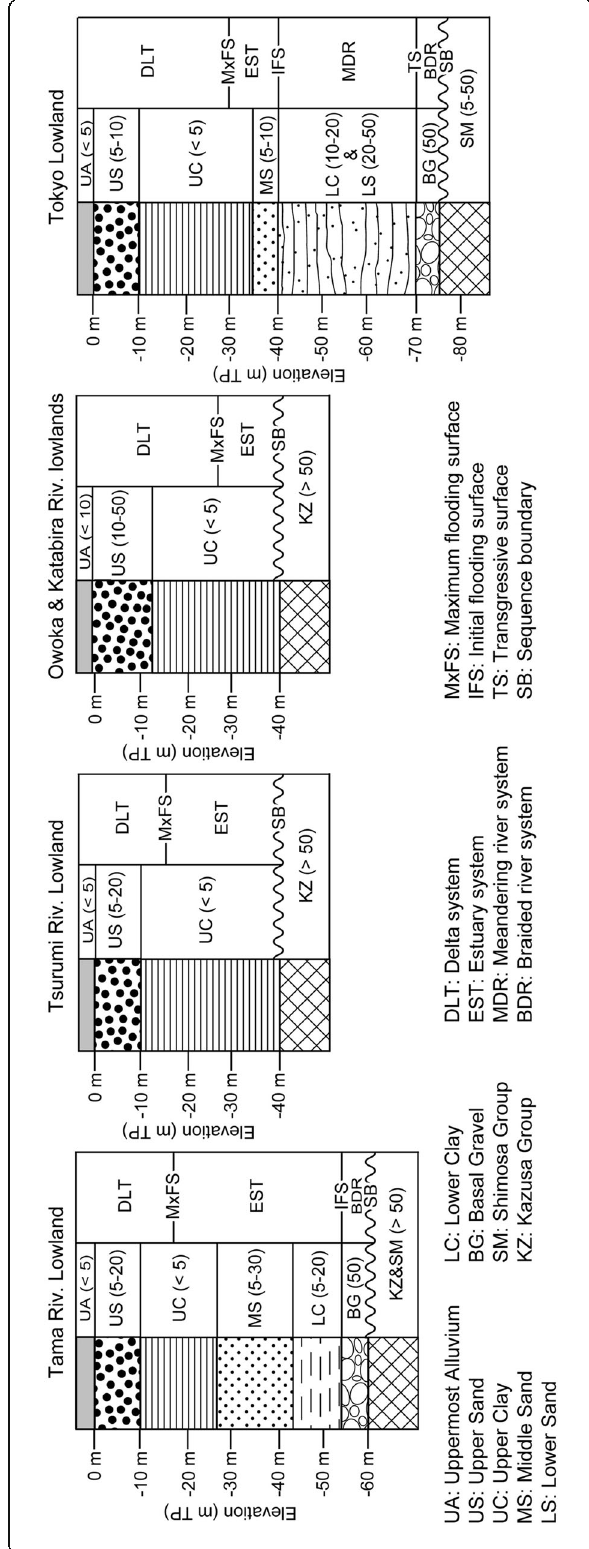
Fig. 5 Correlation of stratotype columns in the Tama, Tsurumi, Owoka, and Katabira river lowlands and the Tokyo Lowland. Lithostratigraphy, sedimentary systems, and bounding surfaces of sequence stratigraphy are correlated as stratotype columns in each